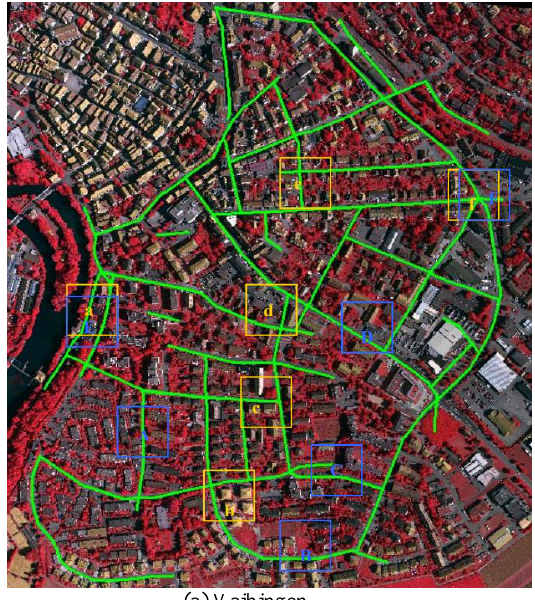
Figure 7. Road network extraction by integrating road intersections with the MTH